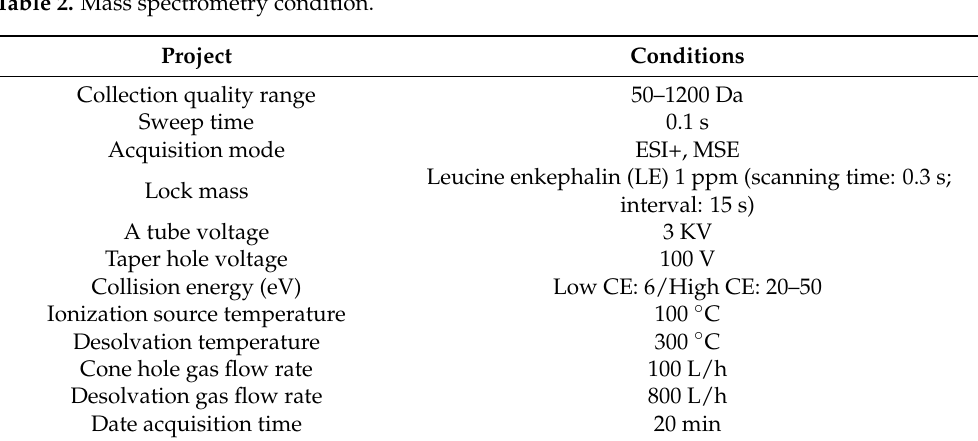
Table 2. Mass spectrometry